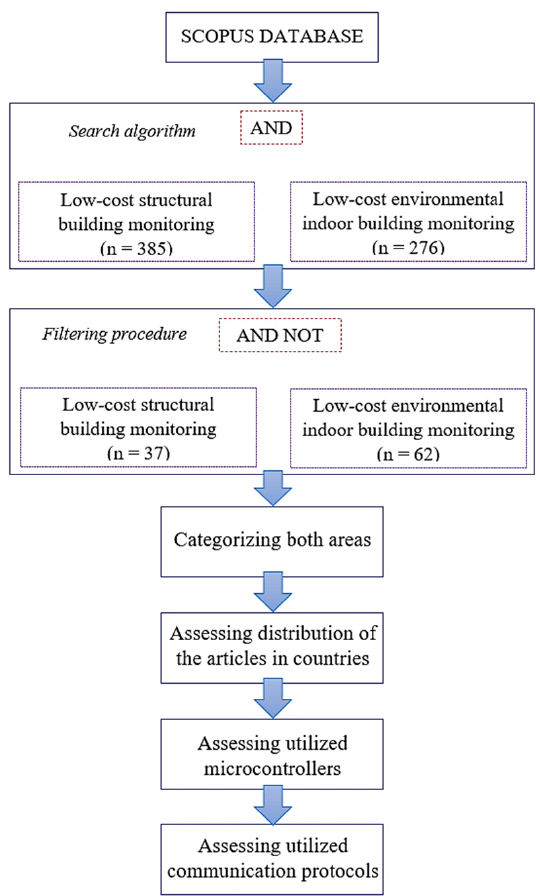
Figure 2. Flow diagram for systematic review.